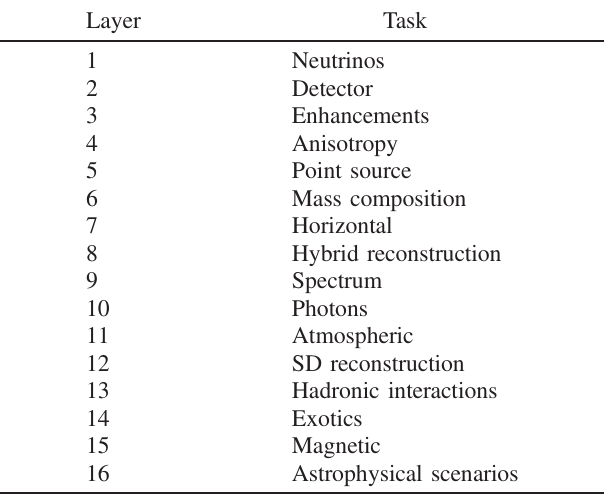
TABLE I. The Pierre Auger Observatory: Each task defines a layer in the multilayer co-authorship network.